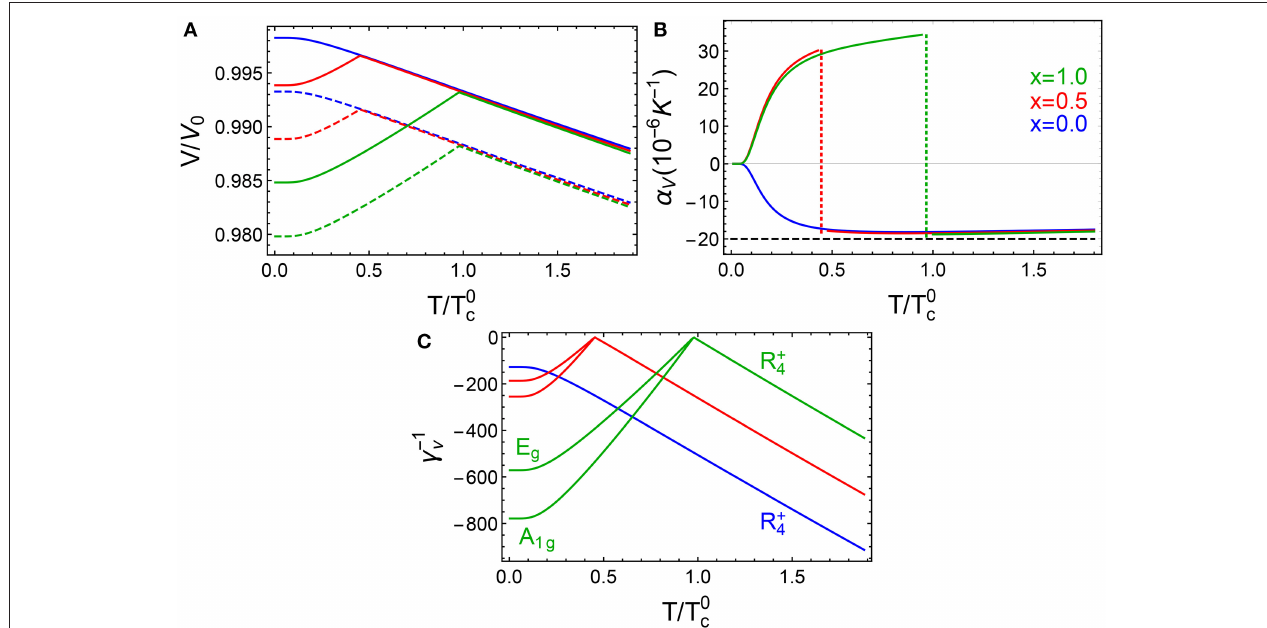
FIGURE 7 | Calculated temperature dependence of (A) volume change, (B) CTE, and (C) Grüneisen parameters for P / P 0 = 0 (solid lines) and 9.0 × 10 − 5 (dashed lines) for Sc 1 − x Ti x F 3 . P 0 is the pressure needed to induce the c-r transition in ScF 3 ( x = 0) at 0K; T 0 c = 340K is the transition temperature of TiF 3 ( x = 1) at ambient pressure. Black dashed line in (B) is the predicted CTE in the classical limit according to Equation (5). The phonon symmetry labels for x = 0.5 in (C) are the same as those for x = 1 and are not shown for